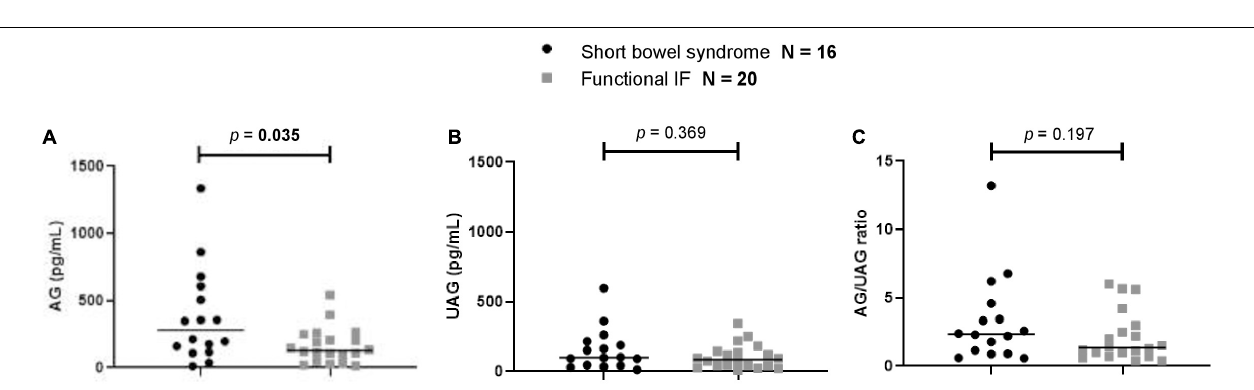
FIGURE 2 | Correlations of AG, UAG levels, and AG/UAG ratio with (A–C) PN-dependency, and (D–F) parenteral glucose intake in g/kg body weight per day in patients with functional IF. AG, acylated ghrelin; IF, intestinal failure; PN, parenteral nutrition; UAG, unacylated ghrelin. Every dot represents one ghrelin measurement. Dots in the same color are from the same patient. Correlations between variables were quantified using Spearman’s rho (r s ).